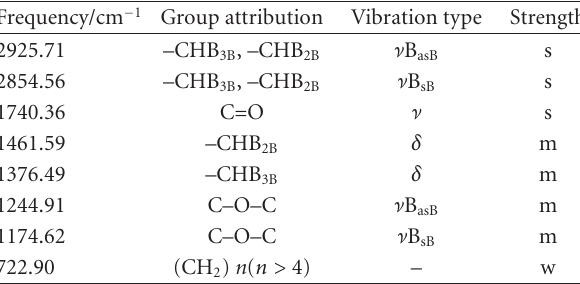
Table 4: Data of FT-IR spectrum of rapeseed oil